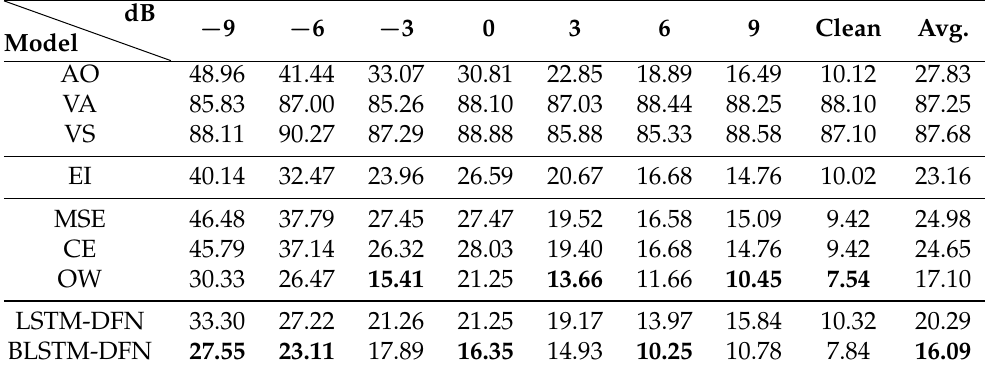
Table 4. Word error rate (%) on the LRS2 test set under additive noise. Model